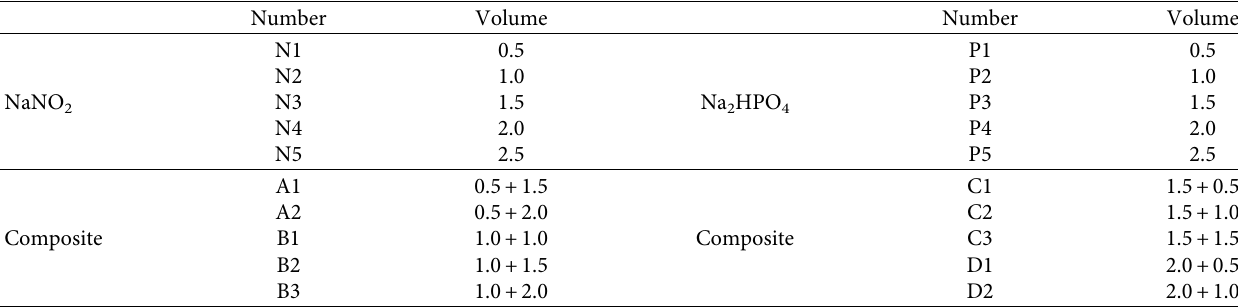
Table 2: Compound proportion of corrosion inhibitors (%).